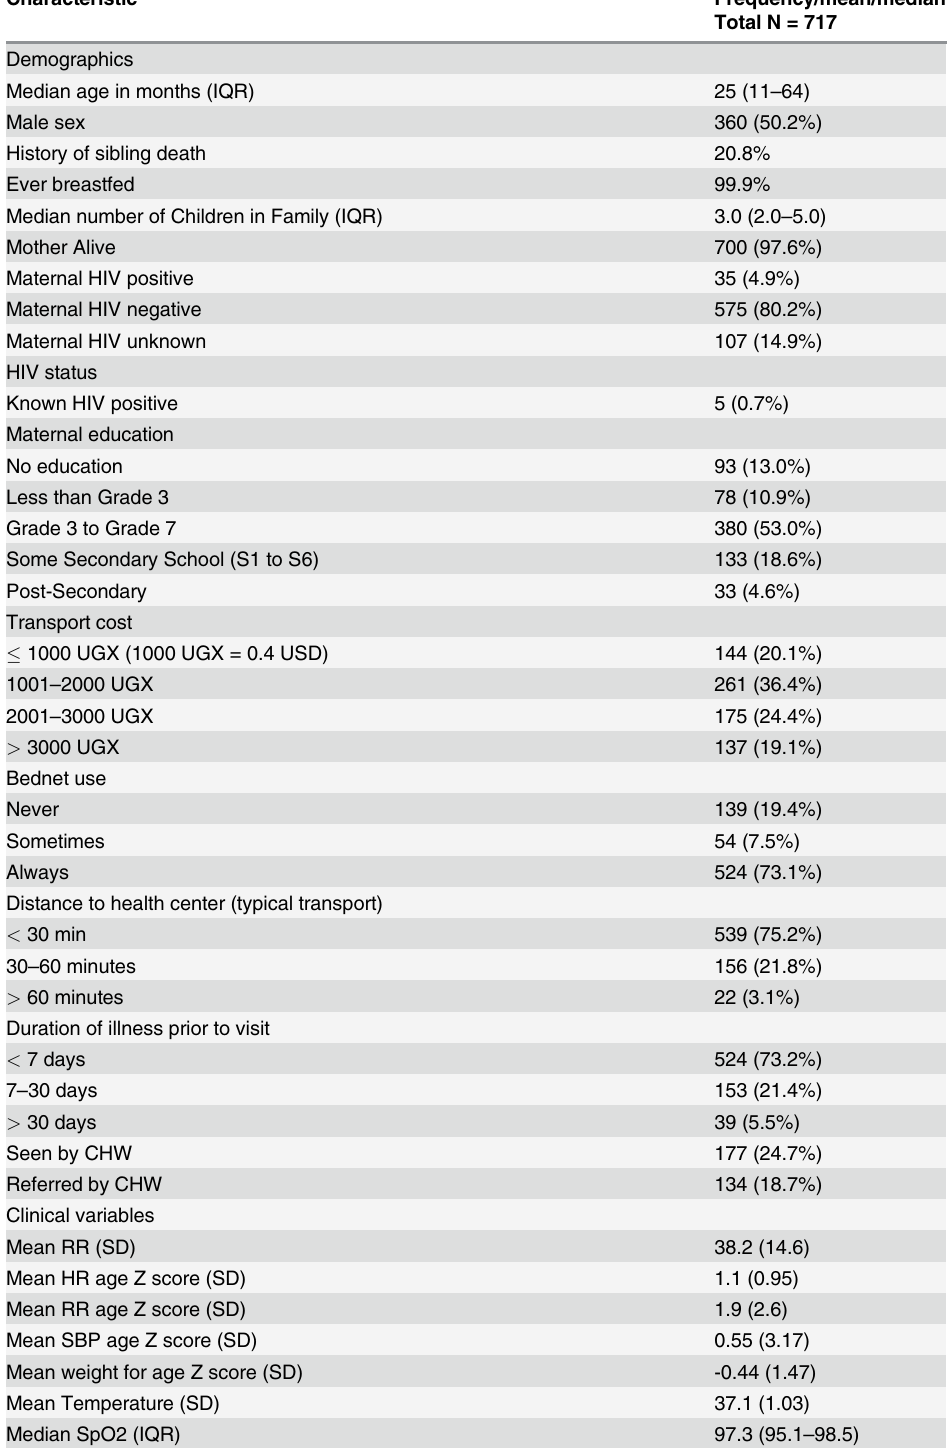
Table 1. Baseline characteristics of study